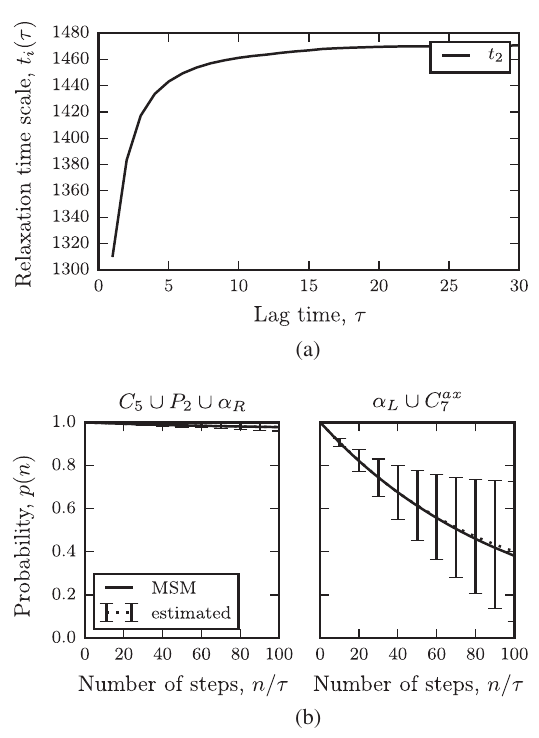
FIG. 13. (a) Implied time-scale test. Convergence of the largest relaxation time scale t 2 indicates a good Markov model fit; i.e., the slow eigenfunction of the associated dynamical operator is well approximated. (b) The Chapman-Kolmogorov test validates the Markov assumption by comparing the evolution of self- transition probabilities predicted by the MSM parametrized at lag time τ with direct estimates from the data at larger lag times n τ .